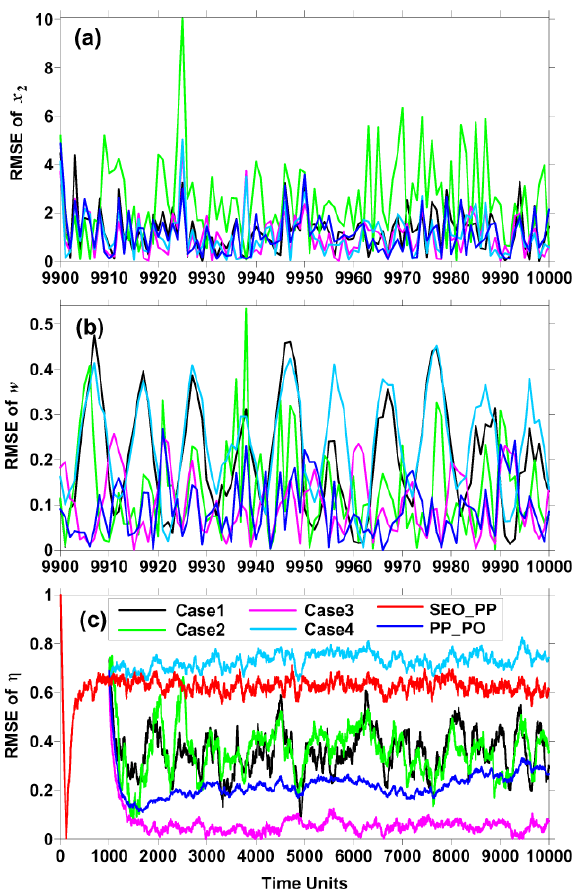
Fig. 7. Time series of RMSEs of (a) x 2 in the last 100TUs, (b) w in the last 100TUs, and (c) η in 10 4 TUs in Case1 (black line), Case2 (green line), Case3 (pink line), and Case4 (cyan line), respectively. The setups of the four experiments are described in Table 1. Note that the time series of RMSEs in SEO_PP (red line; only in c ) and PP_PO (blue line) are also plotted as references.